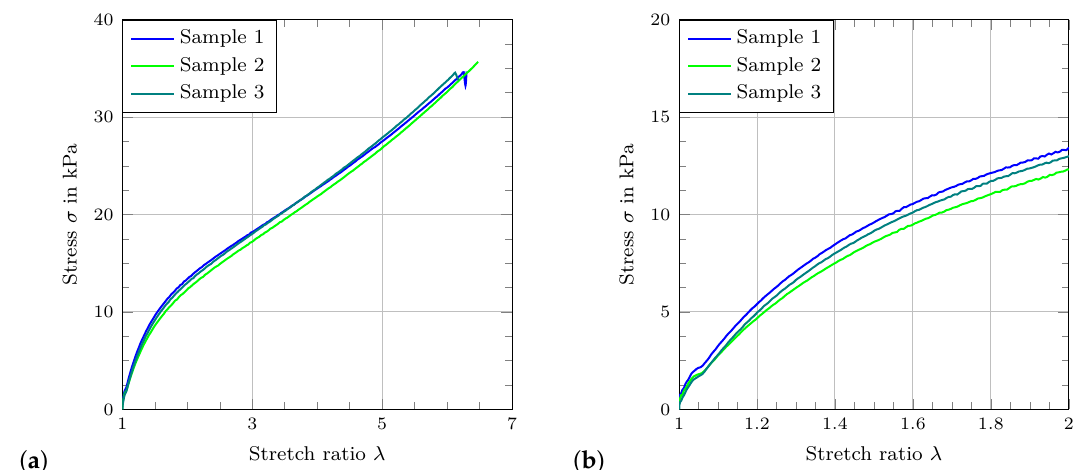
Figure 6. Stress–stretch curves for the tensile tests. ( a ) Results of the measurement until fracture ( b ) zoom-in of the stress–stretch curves in the relevant stretch range.